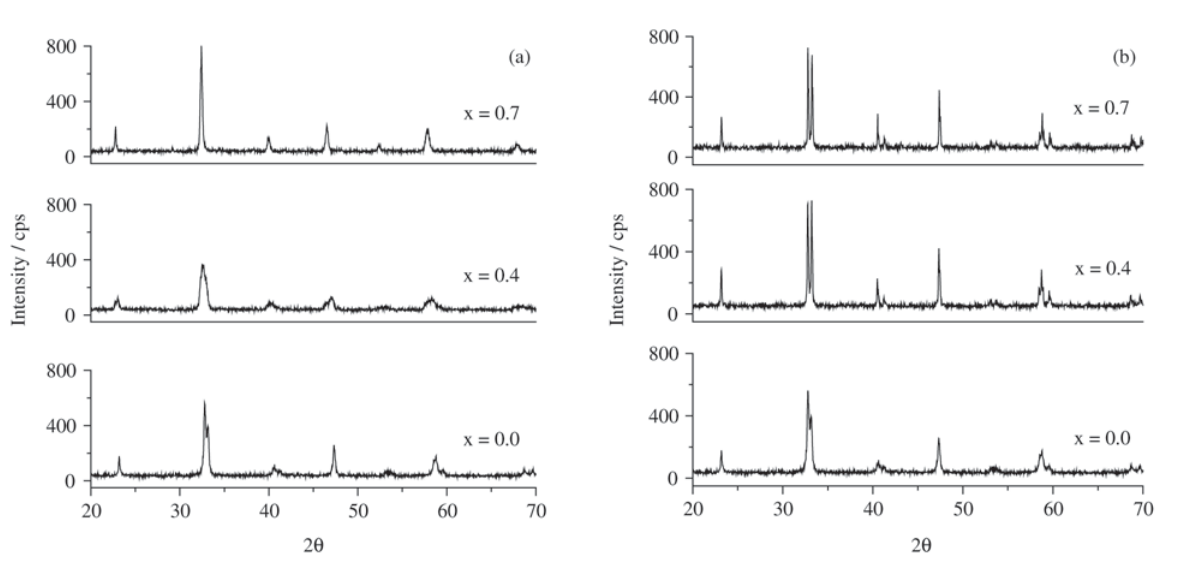
Figure 5. XRD diagrams of perovskites calcined at 900 °C for 10 h. a) LaNi